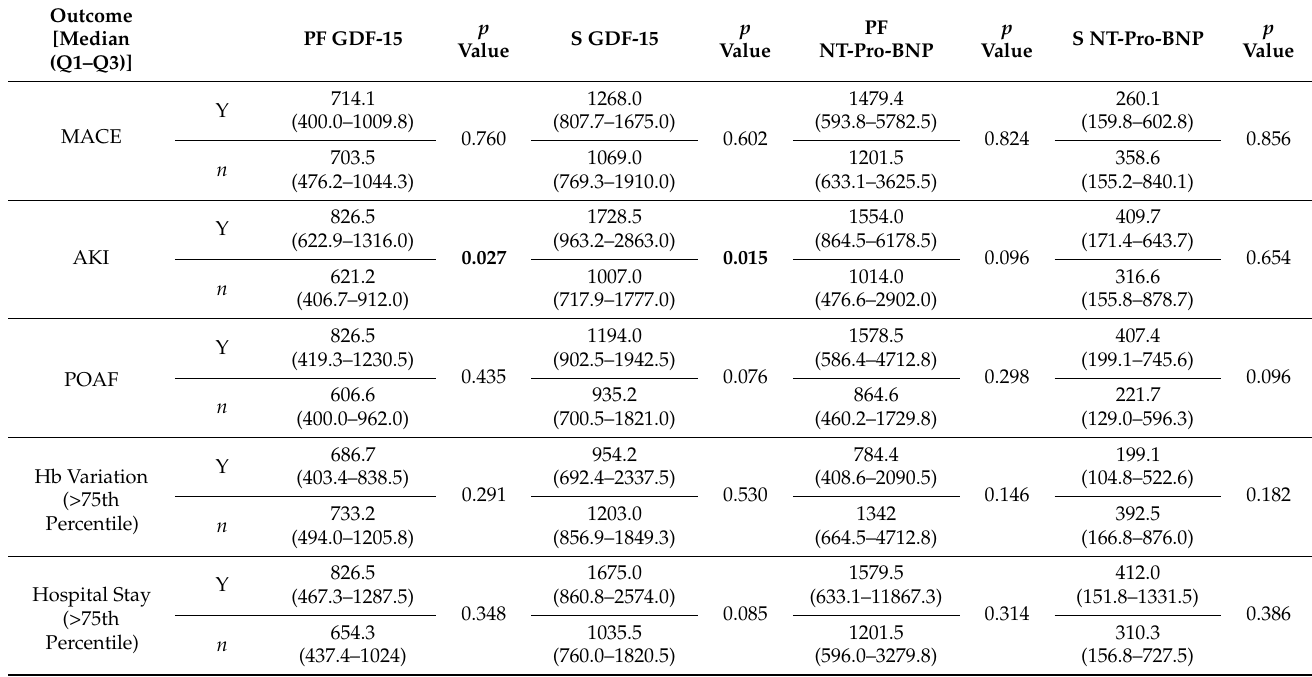
Table 4. Impact of target biomarkers in 30-day postoperative